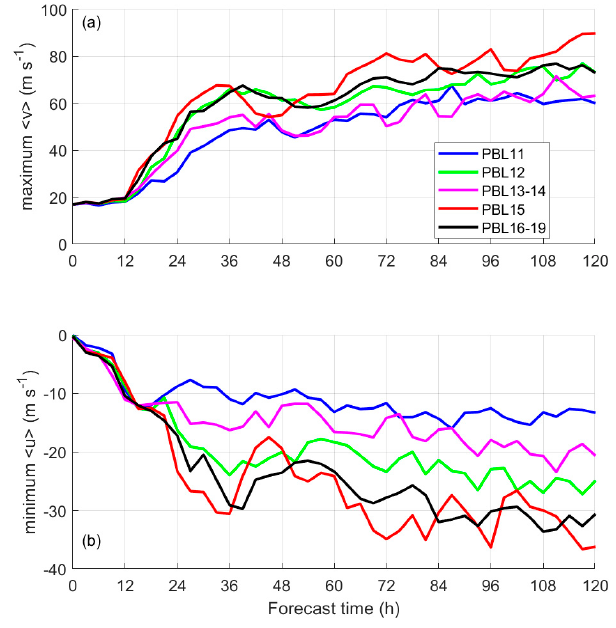
Figure 3. Time series of ( a ) maximum azimuthally averaged tangential wind speed ( < v > max ) and ( b ) minimum azimuthally averaged radial wind speed ( < u > min ) in the five idealized HWRF simulations with different PBL schemes.